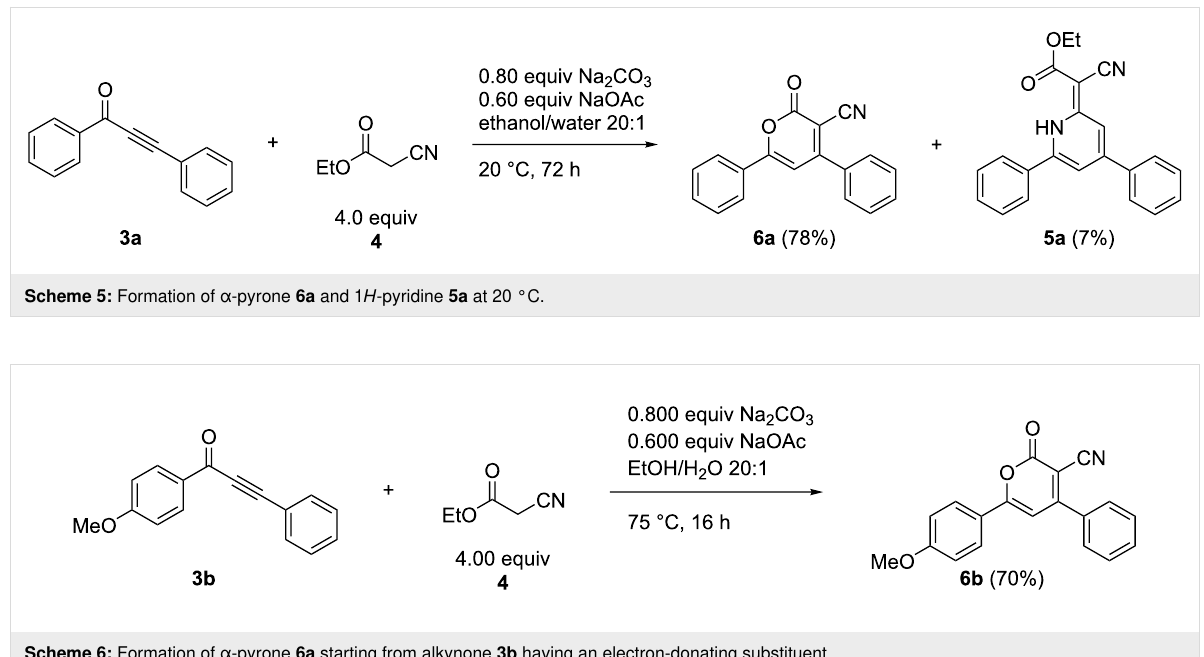
Scheme 6: Formation of α -pyrone 6a starting from alkynone 3b having an electron-donating substituent.